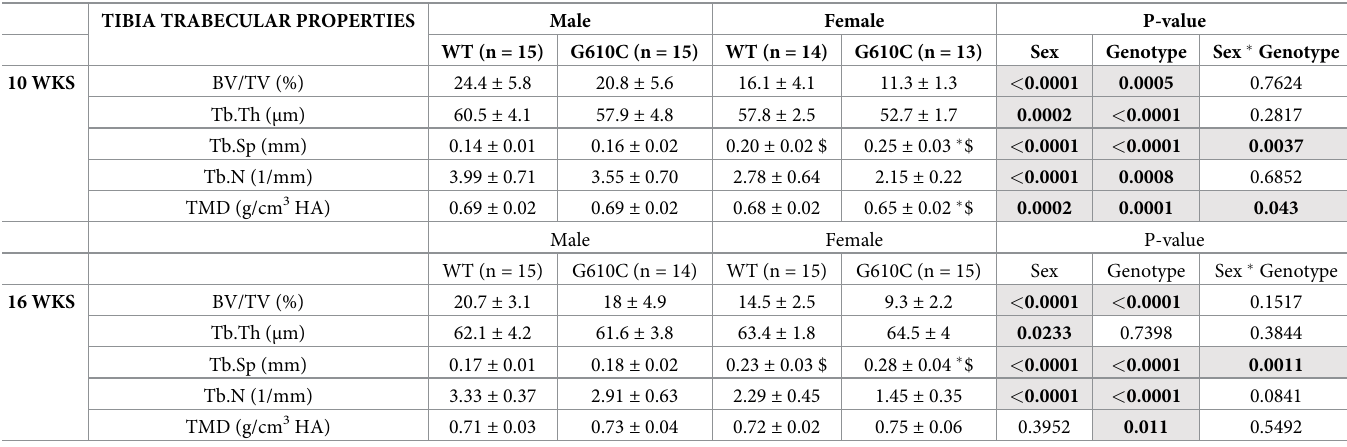
Table 4. Tibia trabecular properties at 10 and 16 weeks, with p-values from 2-way ANOVA. TIBIA TRABECULAR